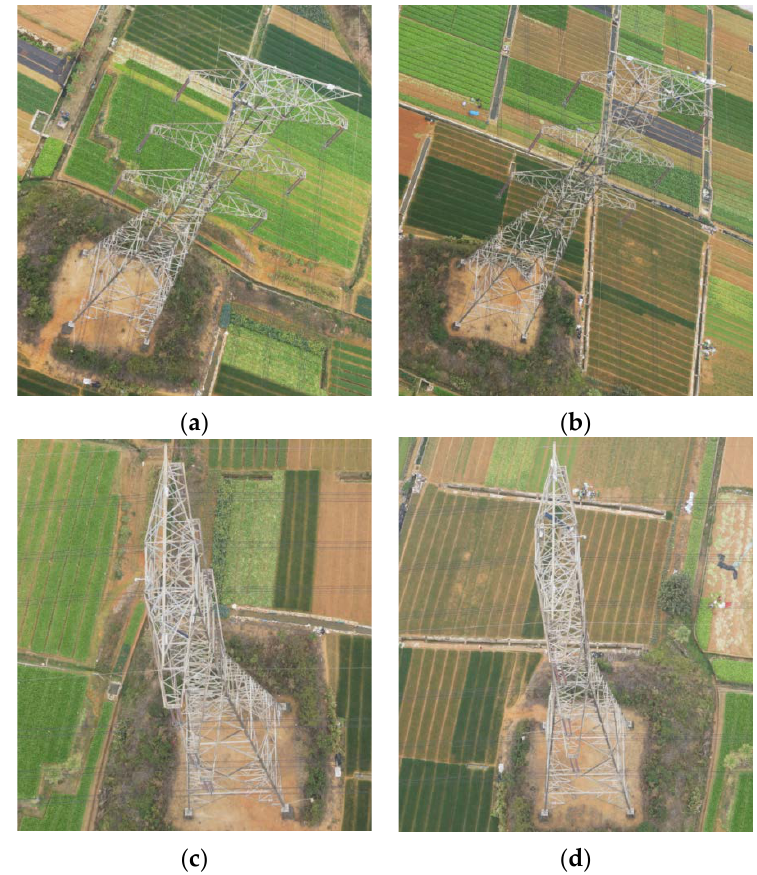
Figure 5. Images taken in test site: ( a , b ) taken by front camera in direction of along-track; and ( c , d ) taken by back camera in direction of across-track.